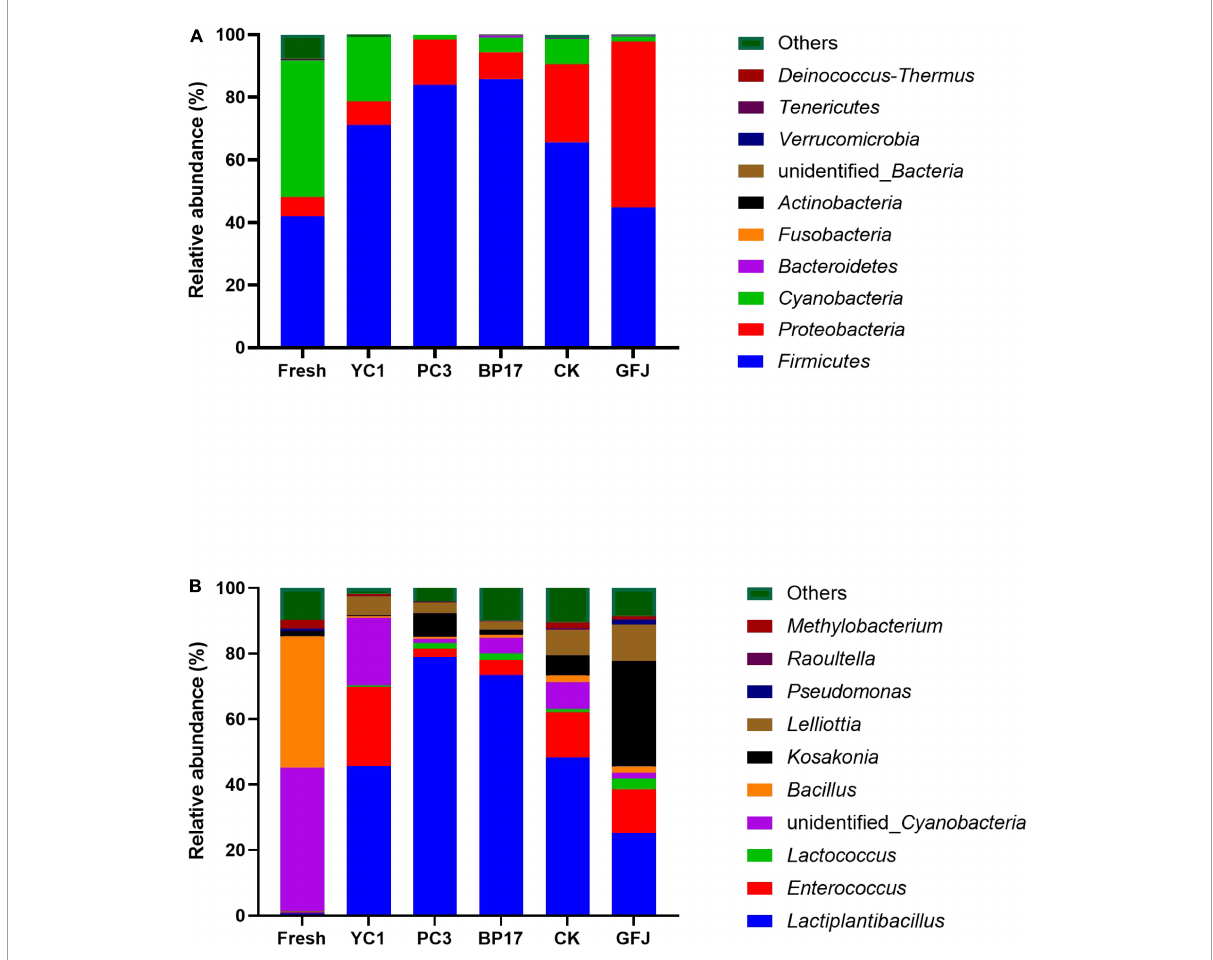
FIGURE1 The relative abundance of bacteria at the phylum (A) and genus (B) levels in fresh paper mulberry and silages inoculated with saline (CK), with a commercial inoculant (GFJ, a combination of Lactiplantibacillus plantarum and Lentilactobacillus buchneri , 1.0 × 10 6 cfu/g of FM) or with one of the three selected strains (YC1, Lactiplantibacillus plantarum ; PC3, Levilactobacillus brevis ; BP17, Lactiplantibacillus plantarum ) at 1.0 × 10 6 cfu/g of